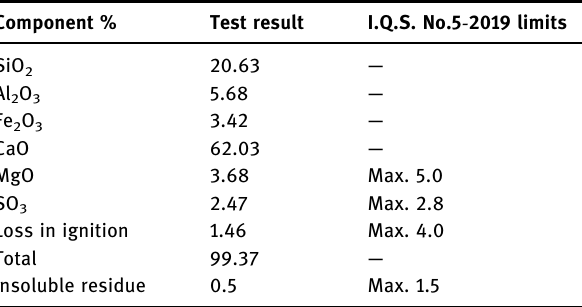
Table 2: Chemical properties of the